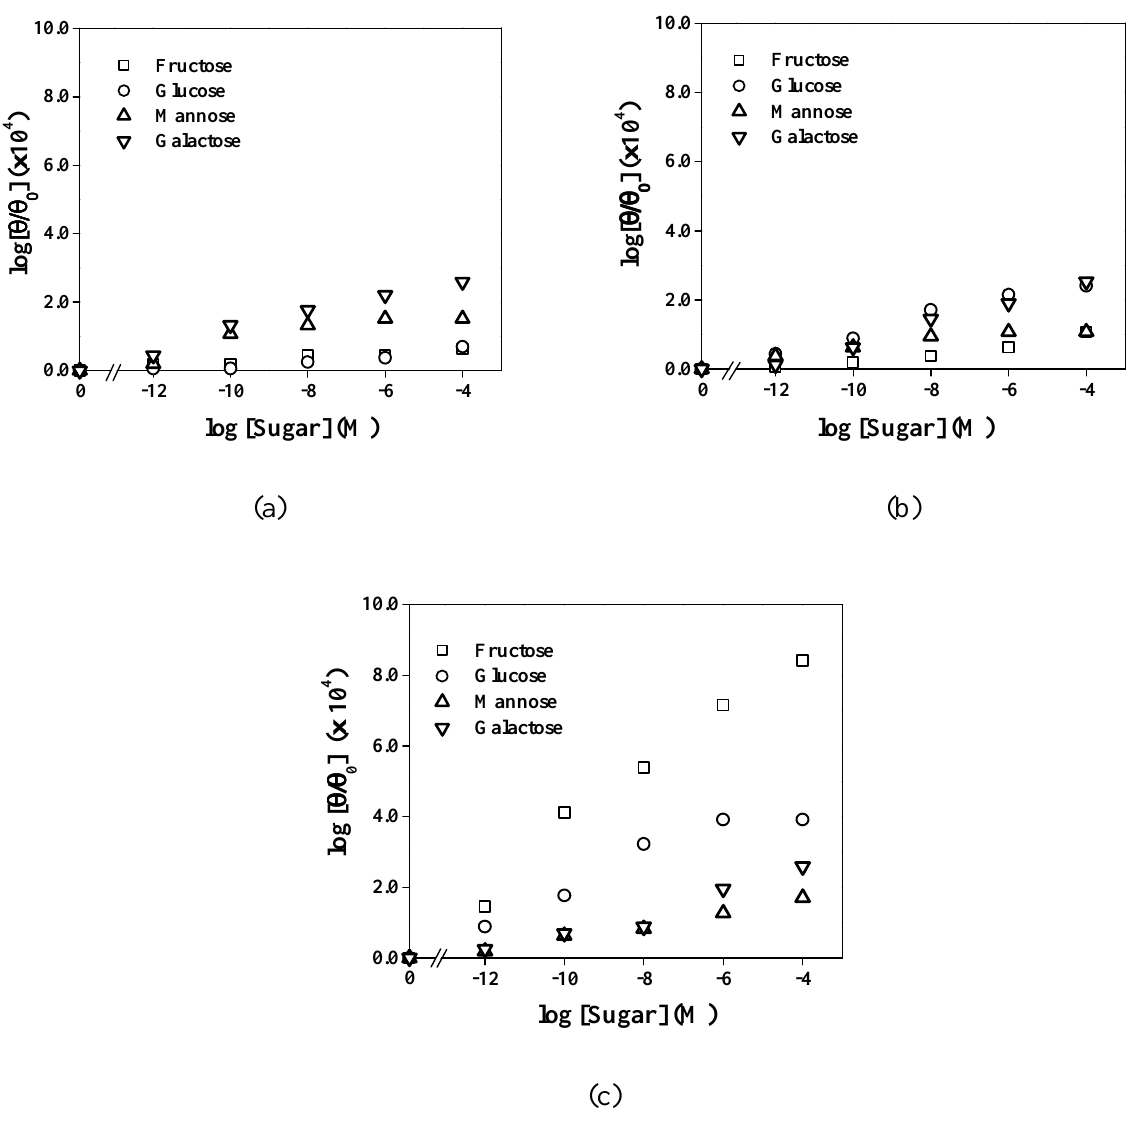
Figure 7 . Relative SPR angle shifts of phenylboronic acid monolayers according to various concentrations of monosaccharides. (a) 1 monolayer; (b) 2 monolayer; (c) 3